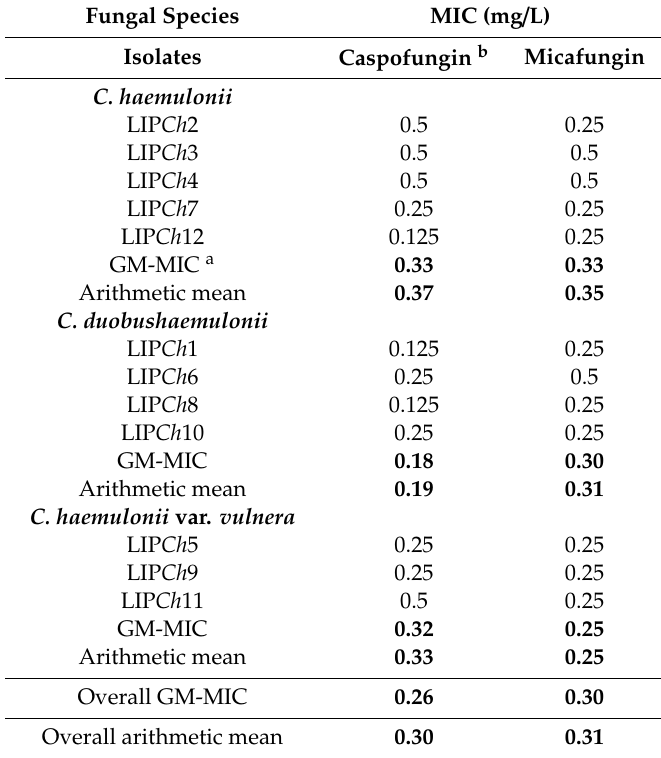
Table 1. MIC values of echinocandins against the C. haemulonii species complex studied